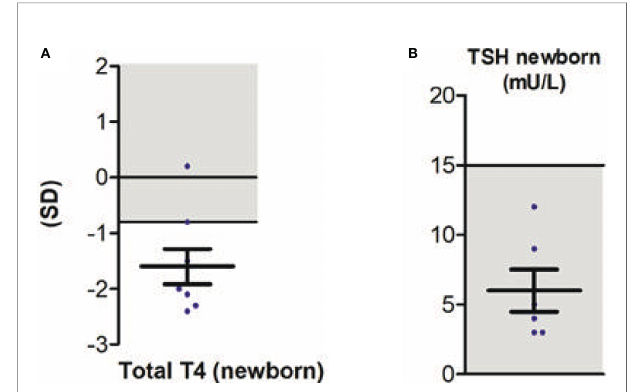
FIGURE 3 | Neonatal screening in patients with MCT8 de fi ciency; total T4 (A) and TSH (B) . Blue dots represent individual data points. Black bars indicate the mean ± SD. Grey areas indicate reference intervals. This fi gure was published in Disease characteristics of MCT8 de fi ciency: an international, retrospective, multicentre cohort study, Lancet Diabetes Endocrinol. 8(7), S Groeneweg et al., Figures 3D and s9I, 594-605, Copyright Elsevier